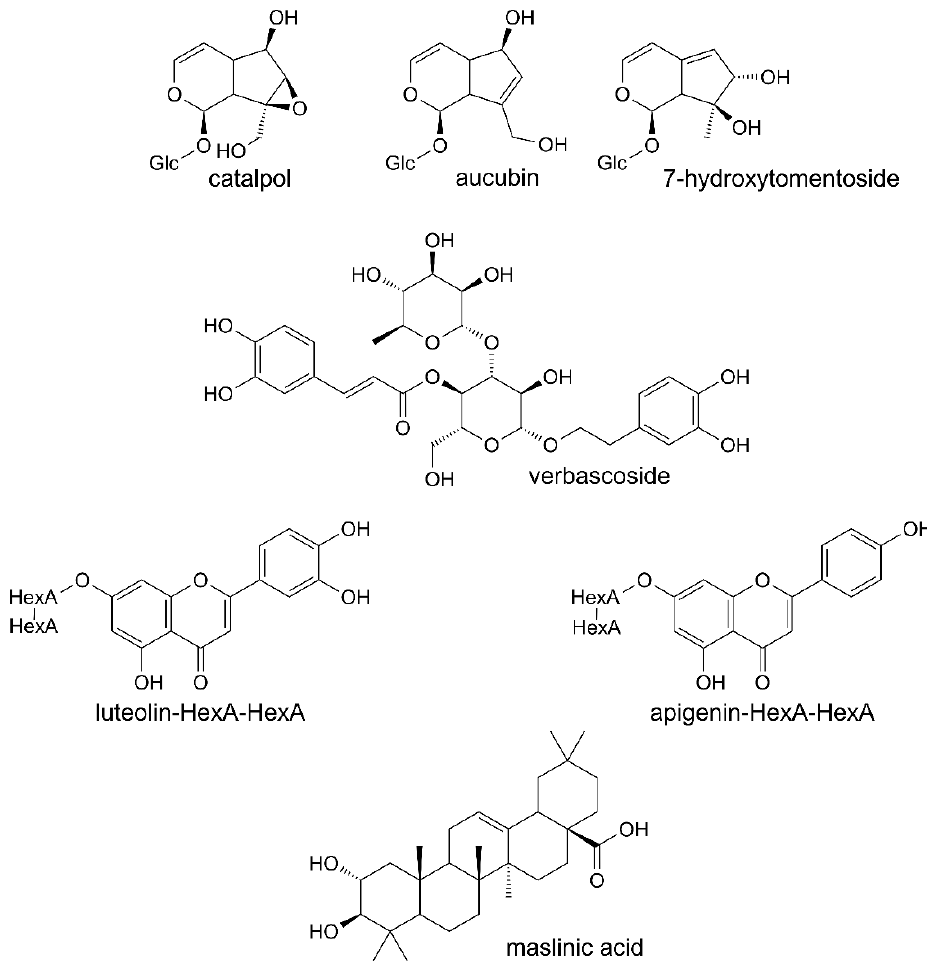
Figure 1. Structures of chosen constituents of the extract and fractions from the leaves of Paulownia Clone in Vitro 112.